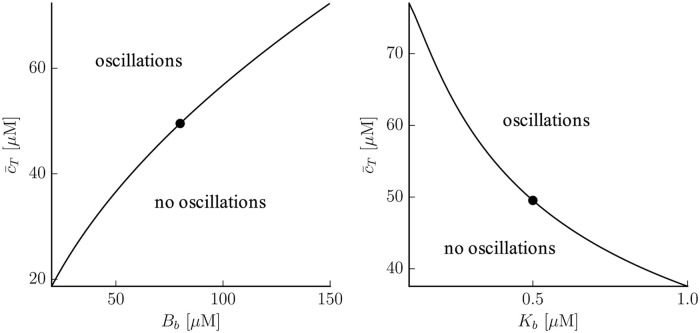
Dependency of the onset of oscillations with buffer parameters.The filled dots represent the control values Bb = 80μM, Kb = 0.5μM, given in Table 2 in S1 File.